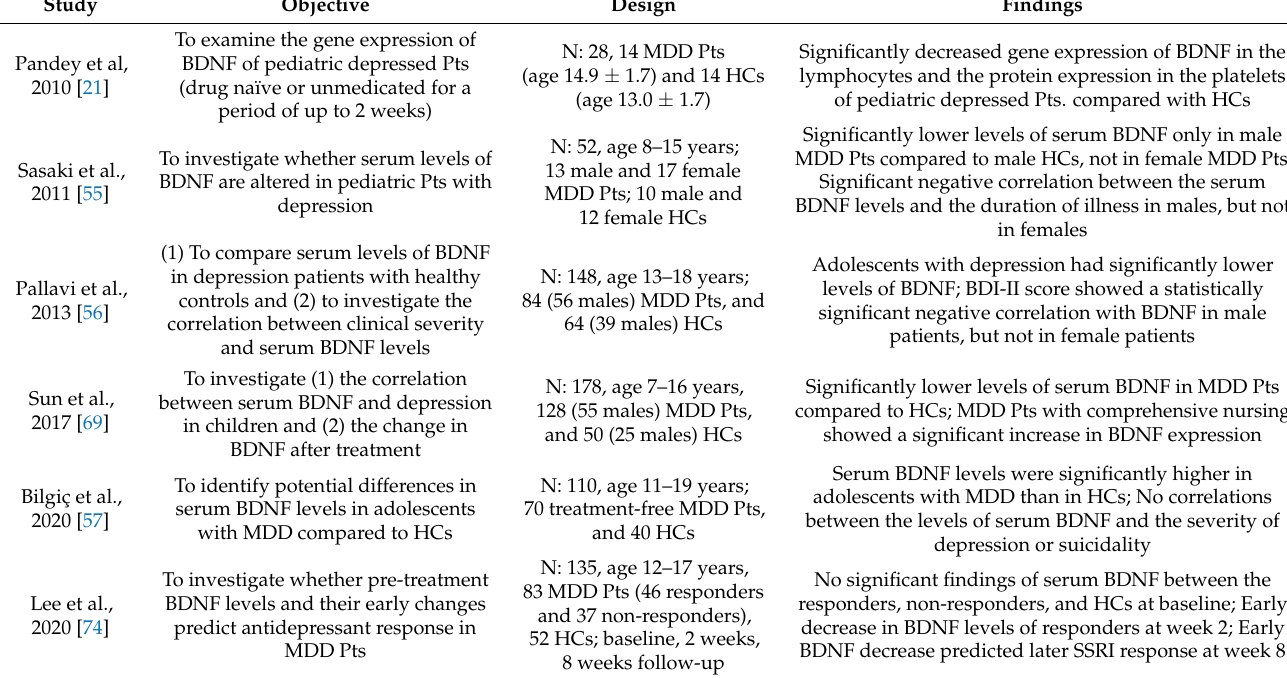
Table 2. Previous studies of BDNF in pediatric depressive